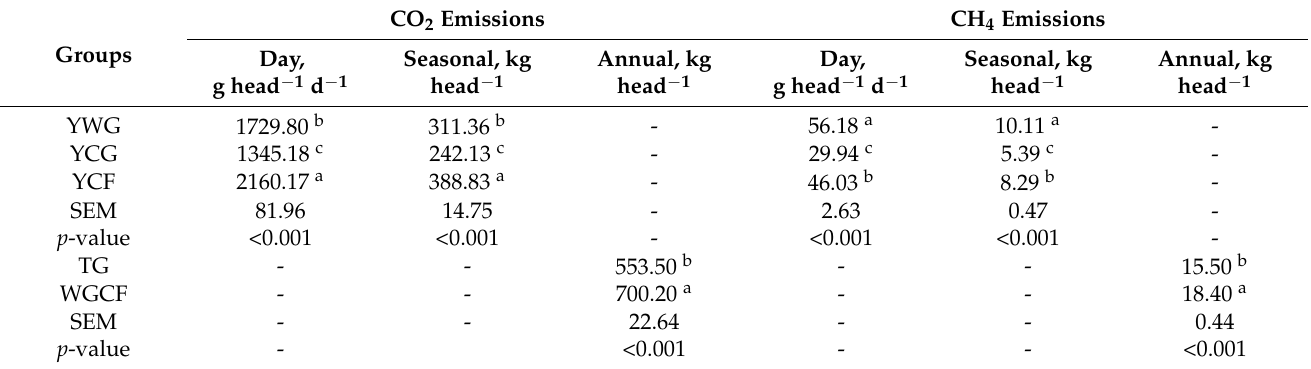
Table 3. The day, seasonal, and annual cumulative CO 2 and CH 4 emissions from yaks.